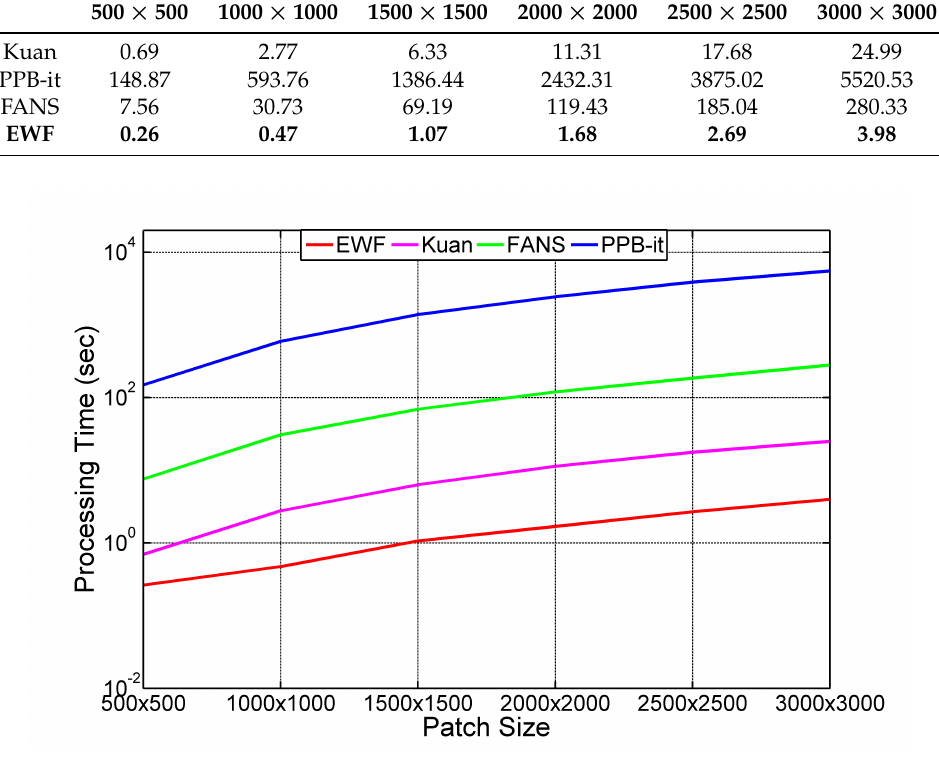
Figure 22. Processing time evolution (in logarithmic scale) performed by the filtering algorithms as a function of patch size variation related to the Chicago City Sentinel-1 SAR